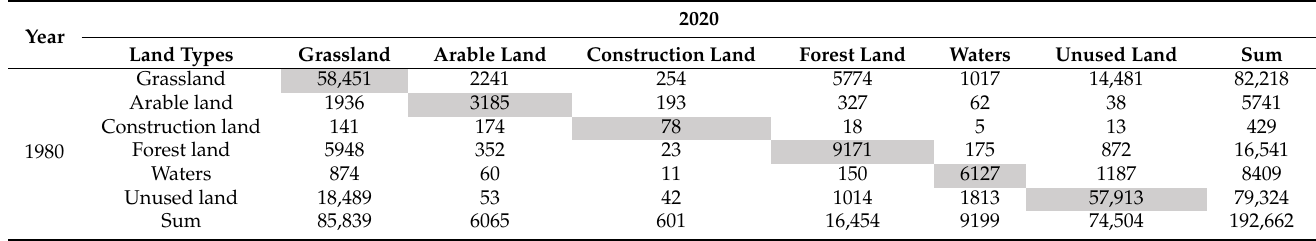
Table 8. Land use transfer matrix in the Qilian Mountains from 1980 to 2020 (km 2